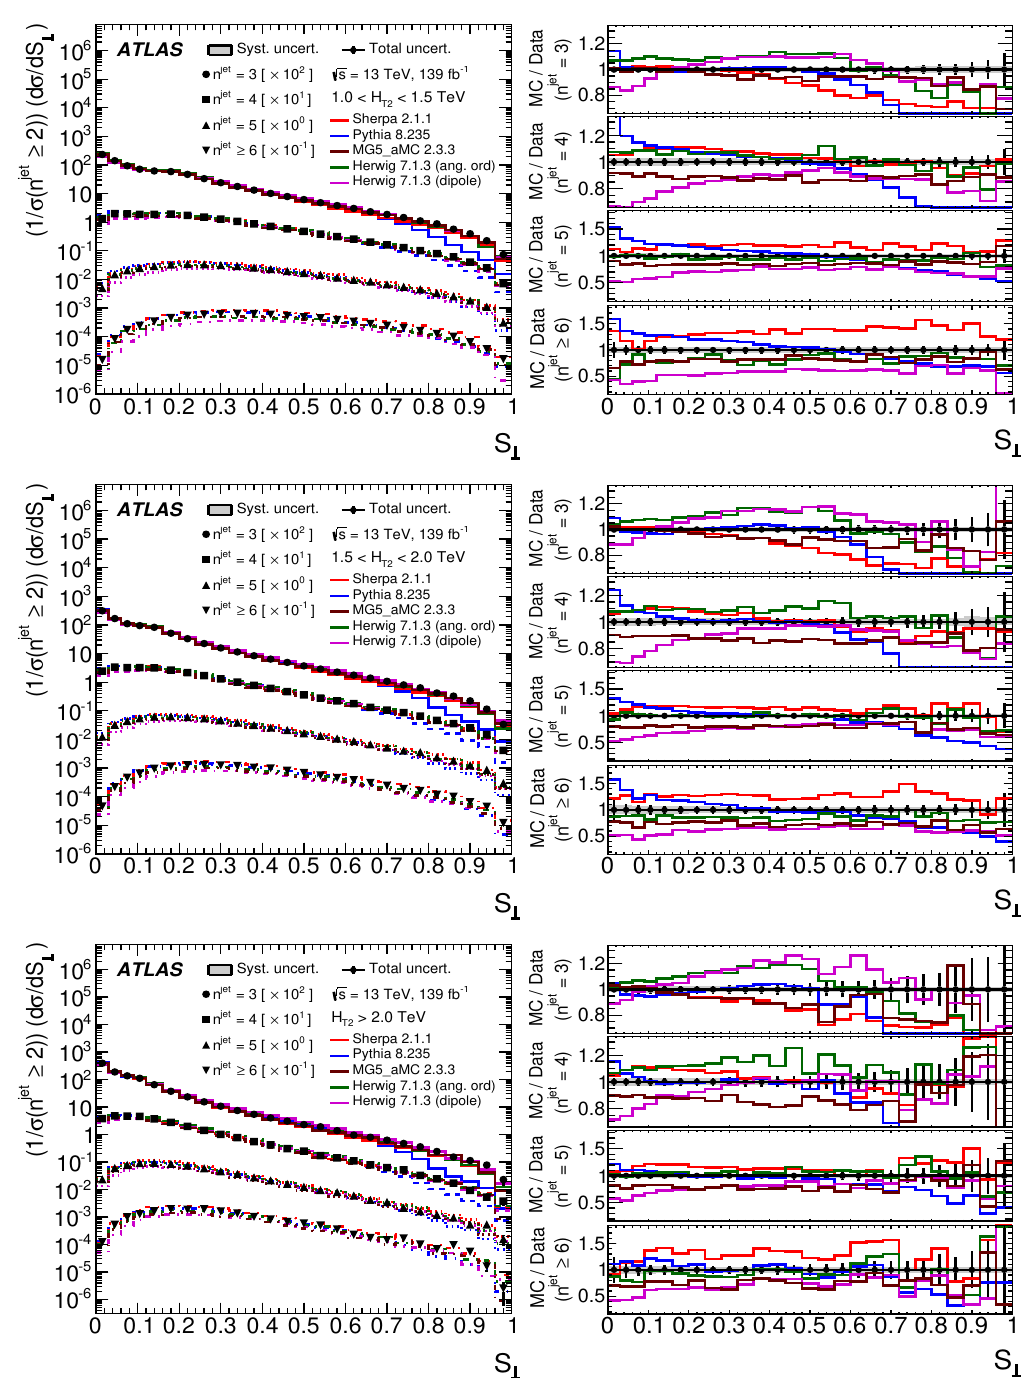
Figure 7 . Comparison between data and MC predictions as a function of the transverse sphericity S ⊥ (see eq. 3.4) for different jet multiplicities and energy scales. For illustration purposes, the corresponding differential cross section for each jet multiplicity is multiplied by 10 2 ( n jet = 3), 10 1 ( n jet = 4), 10 0 ( n jet = 5), 10 − 1 ( n jet ≥ 6). The right panels show the ratios between the MC and the data distributions. The error bars show the total uncertainty (statistical and systematic added in quadrature) and the grey bands in the right panels show the systematic